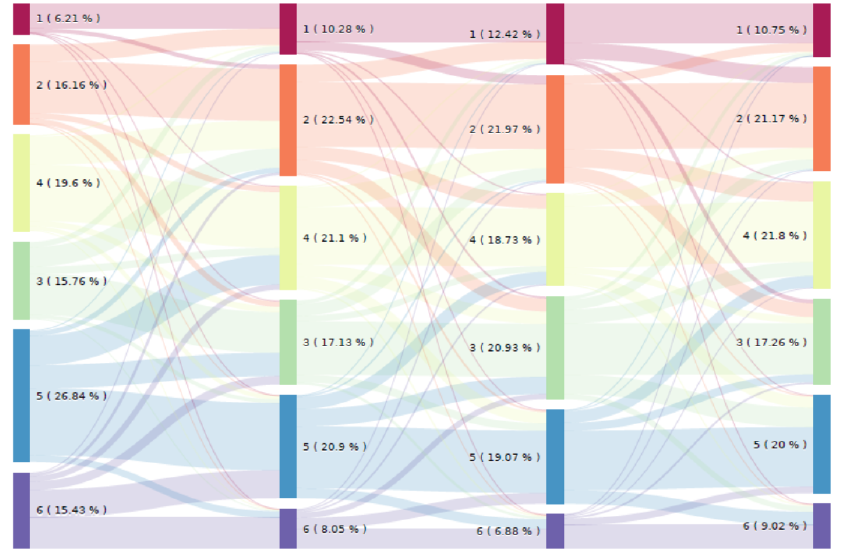
Figure 9. Change in consumer behavior over the months of one year.